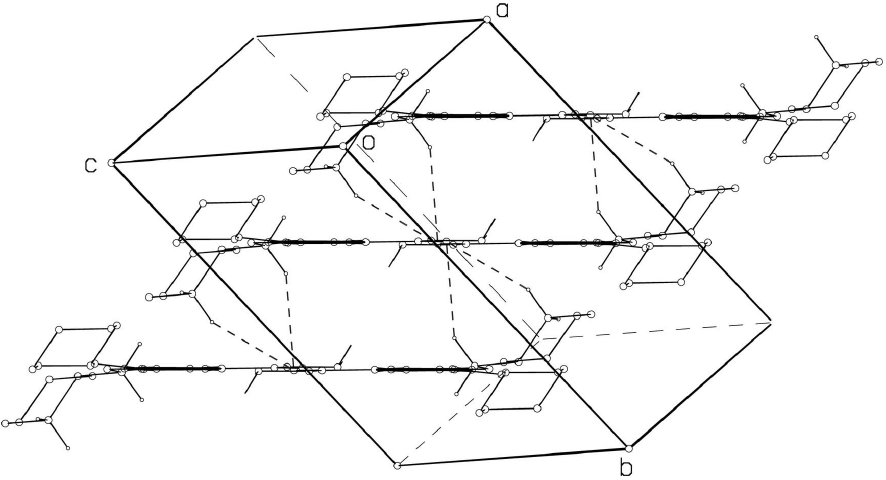
Figure 4 Stacking of molecular pairs related by translations along the a axis. The dashed lines represent the proposed long C— H···O hydrogen bonds. This figure is related to Fig. 3 by rotation of 90° about the horizontal axis. Methyl 3,5-bis(cyclohexylmethoxy)benzoate Crystal